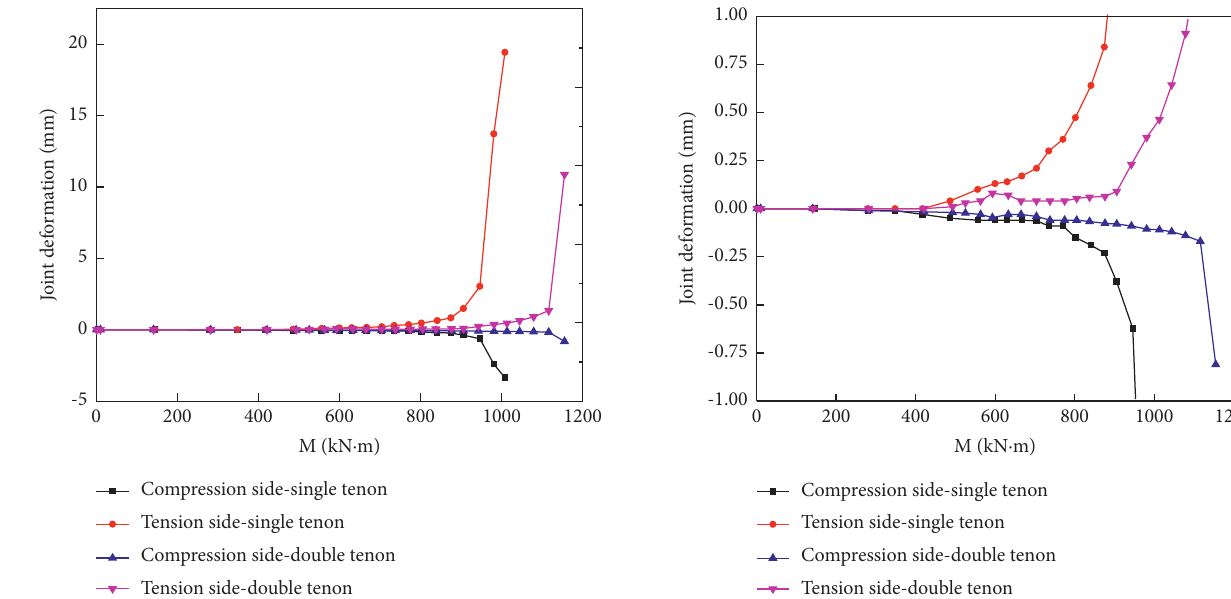
Figure 16: Comparison of joint deformation for single-tenon and double-tenon joints.